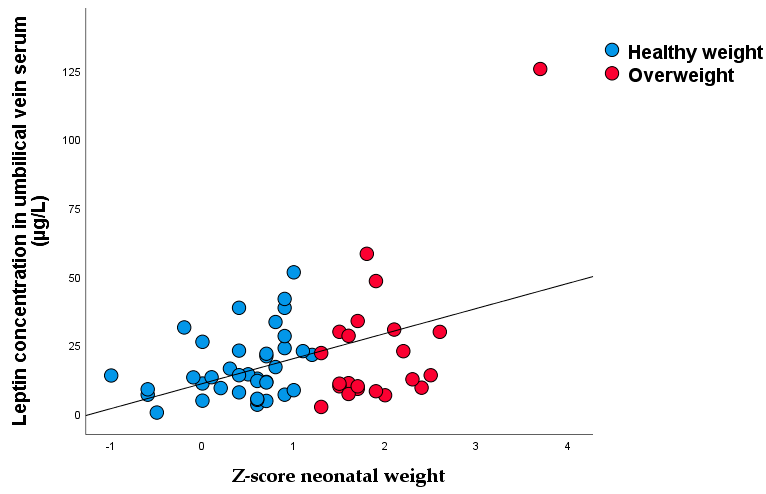
Figure 6. Linear regression of between z-score of neonatal weight and leptin in umbilical vein serum (r = 0.431, p = 0.001).